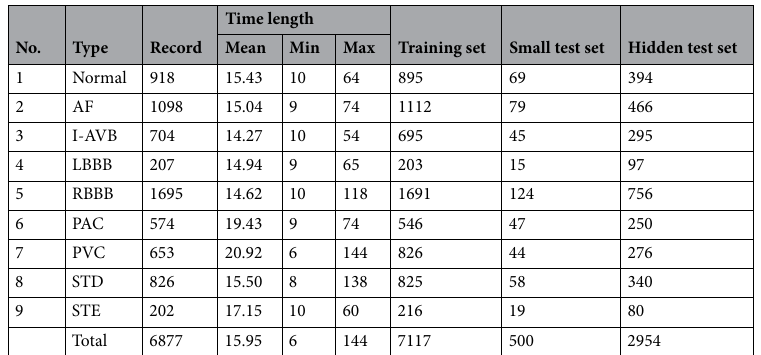
Table 1. Data profile.